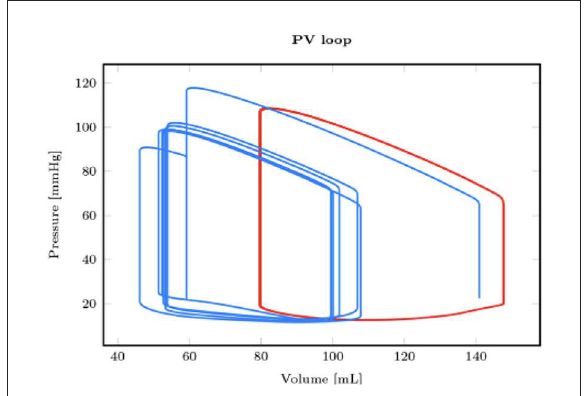
FIGURE1 Comparison between a reference healthy pressure-volume loop in sinus rhythm (red) and the one obtained in hemodynamically tolerated ventricular tachycardia [reproduced with permission from (19)].